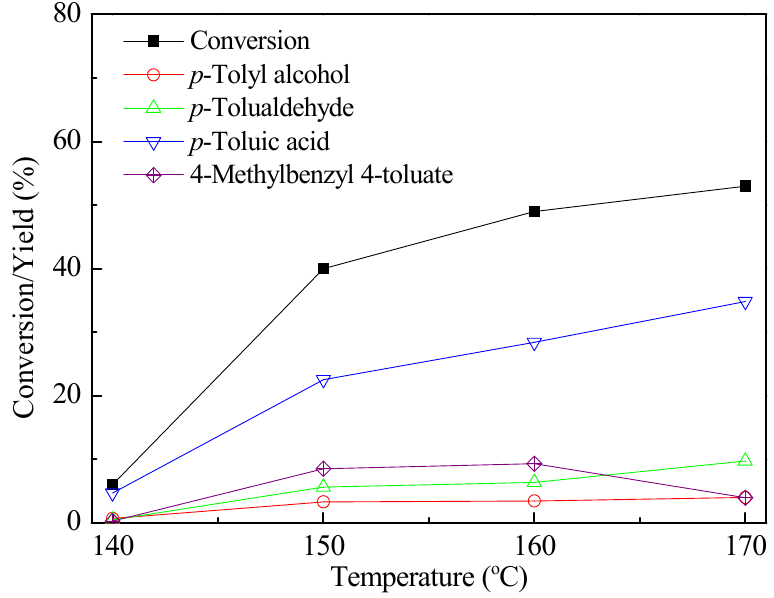
Figure 3. The influence of temperature; reaction conditions: p -Xylene (100 mmol), DMAP